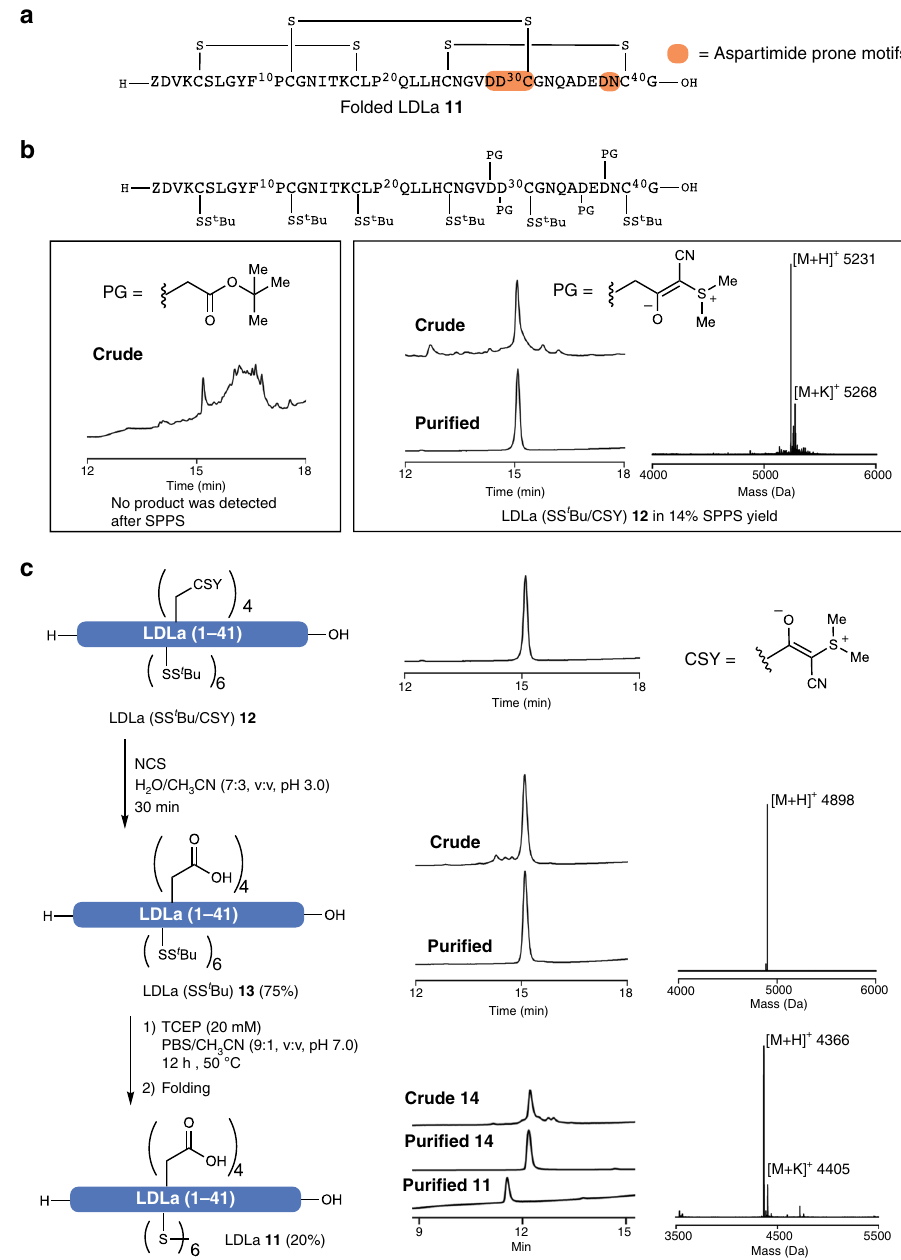
Fig. 5 Chemical synthesis of LDLa using CSY. a Sequence of LDLa 11 with sequence motifs that are prone to aspartimide formation are highlighted. Z = pyroglutamic acid. b SPPS was carried out using standard conditions. Synthesis with conventional tert-butyl ester protected Asp was not successful, whereas LDLa(S t Bu/CSY) 12 was observed as major product using Fmoc-Asp(CSY)OH 3 monomers. c In solution deprotection of cyanosulfurylides using a stoichiometric amount of NCS provides LDLa(S t Bu) 13 in good yield (75%). Cysteines were deprotected using TCEP (20 mM) in PBS/CH 3 CN (9:1) giving unfolded LDLa 14 (55%) that was folded to provide LDLa 11 (36%). Detailed folding conditions for 14 are provided in Methods and Supplementary Figs. 11 and